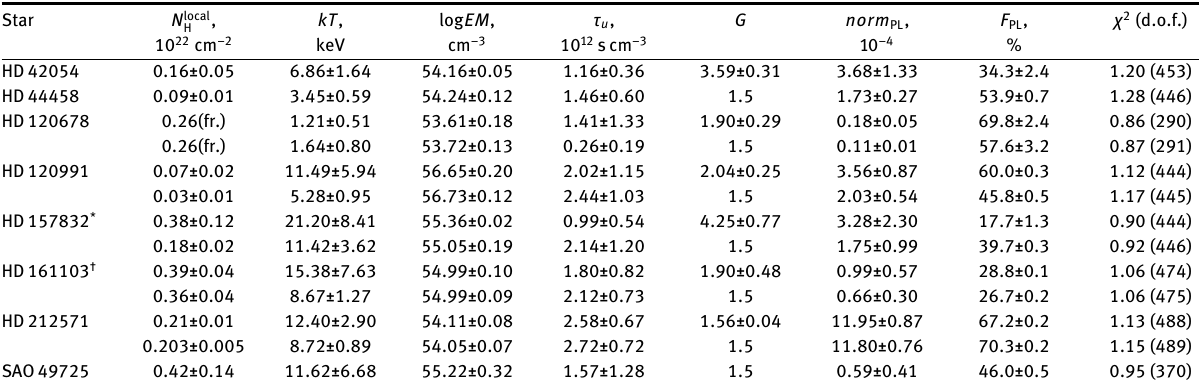
Figure 3 shows the examples of the fits of X-ray spectra by APEC/MEKAL+PL model. The analogical fits of spec- tra of the same stars but with the fixed value G = 1.5 are presented in Figure 4. Analyzing these figures, one can con- clude that an additional PL component makes it possible to describe the X-ray spectra of γ Cas analogues with accept- able temperatures of hot plasma. Parameters of the fit for the model combination PSHOCK+PL are given in Table 7. Both free and fixed val- ues of the spectral index G= 1.5 are used. For all the stars excluding HD 157832 we use fixed Abundance = 1.0. For HD 157832 we accept the parameter Abundance = 0.54 ± 0.25. Also as for the APEC/MEKAL+PL combination the models with the PL component allows us to decrease the plasma temperatures to the acceptable temperatures. Figure 5 demonstrates the fits of X-ray spectra by APEC/MEKAL+PL model with parameters given in Table 7. We are not able to fit spectra of V 2156 Cyg and HD 316568 stars because these spectra are very faint and noisy. We calculate only model independent characteristics of X-rays from these